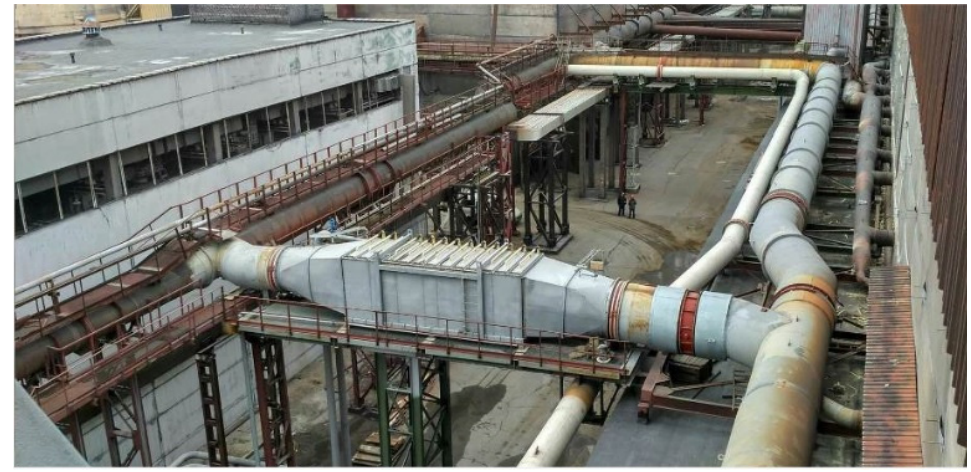
Figure 14. Gas ducts derived from the electrolytic cells of the RA400, RA500 series.